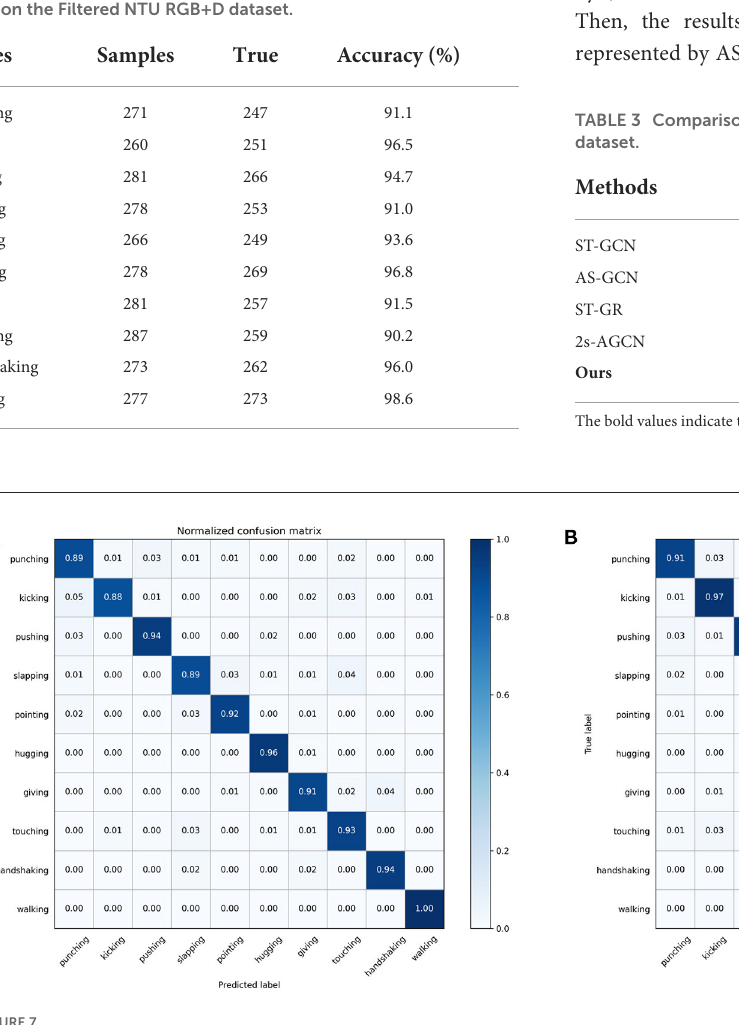
FIGURE7 Normalized confusion matrix of 10 types of human action. (A) Confusion matrix of 2s-AGCN model. (B) Confusion matrix of our